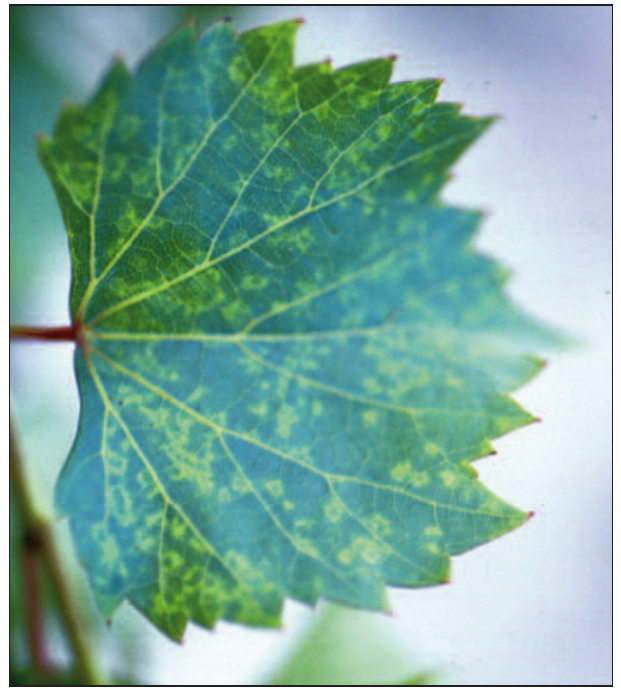
Figure 4. Arabis mosaic (ArMV) – shock symptoms (chlorotic rings and lines) in Vitis